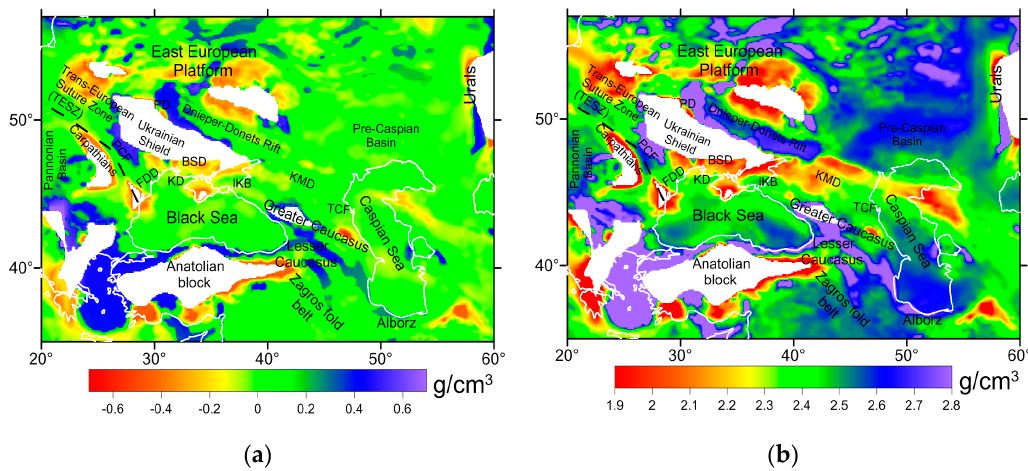
Figure 8. ( a ) Corrections for the initial (vertically averaged) density of sediments; ( b ) final model of the average density of sediments.